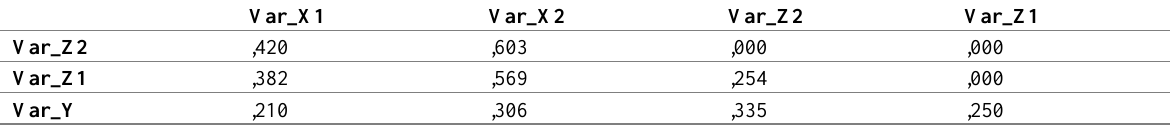
Table 4: Standardized Total